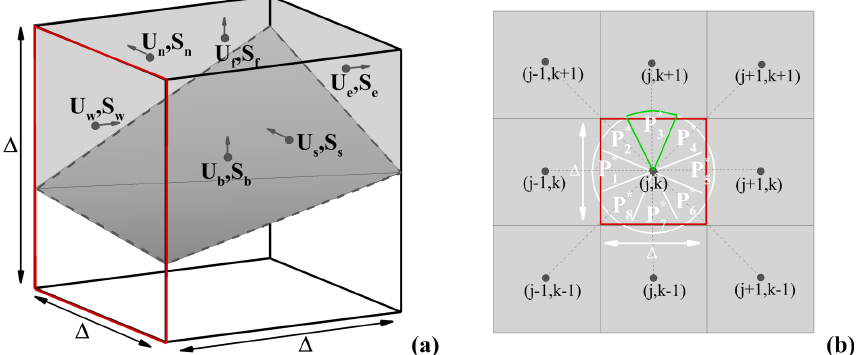
Figure 5. (a) Momentum flux balance for an arbitrary truncated cell of volume V , where the u i ∗ velocities ( U i in the figure, i = [ e,w,n,s,b,f ] ) are supported by the S i surfaces in grey; the transparent volume is a part of the solid body. (b) Segmentation of the S w arbitrary surface (red border) in eight P ∗ p pieces of cake (the border of P ∗ M P P − 1 . Q m , where M is the number of iterations. cct m = 1